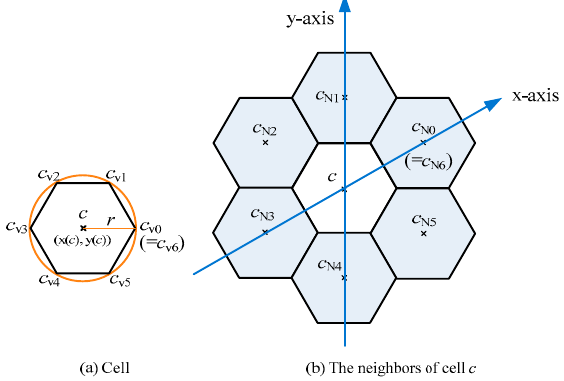
Figure 1. Cell architecture, a cell is a regular hexagon area. ( a ) For cell c with radius r , c V0 , c V1 , c V2 , c V3 , c V4 , c V5 are its six vertices. Moreover, c V6 represents vertex c V0 . ( b ) The neighbors of cell c represent as c N0 , c N1 , c N2 , c N3 , c N4 , c N5 . Moreover, cell c N6 represents cell c N0 . Table 1. The vertices of cell c . For a cell c with radius r , the coordinates of each vertex are as follows. Vertex